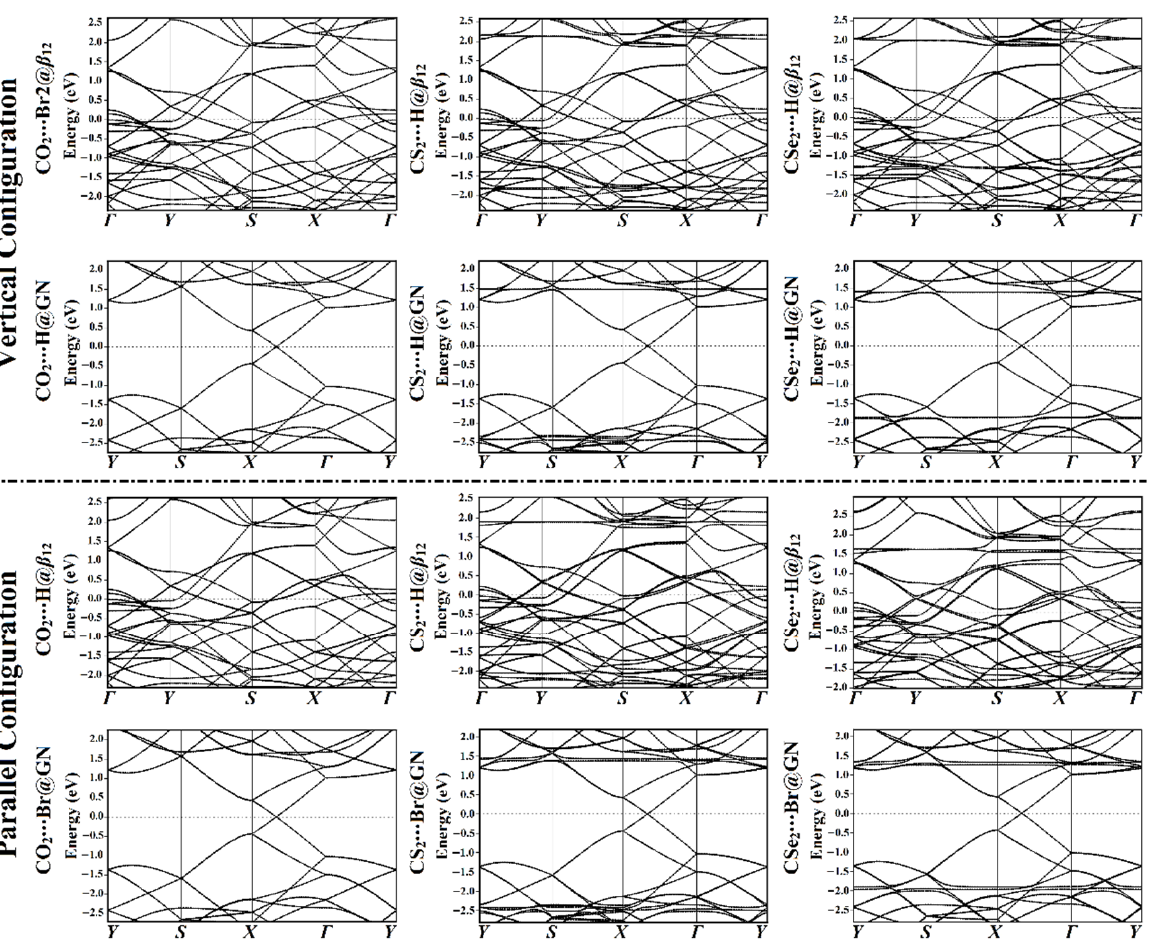
Figure 4. The plots of band structure for the relaxed structures of the vertical and parallel configurations of the CX 2 · · · β 12 /GN complexes (where X = O, S, or Se) at the most favorable energetic sites on the high-symmetry path of the Brillouin zone (BZ). The Fermi level is located at zero energy.